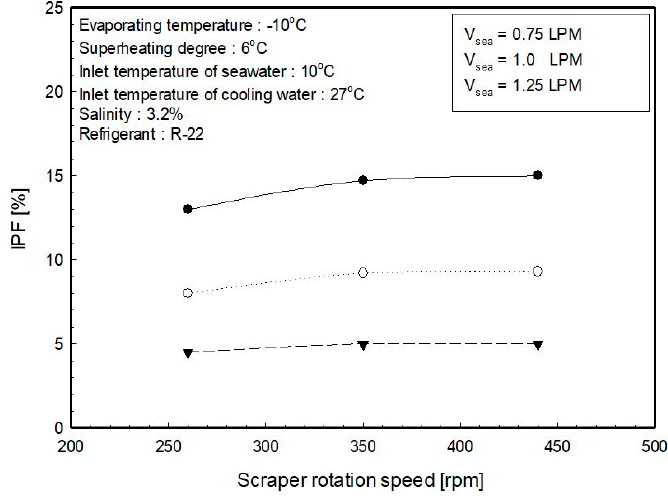
Figure 12. IPF with respect to scraper rotation speed.